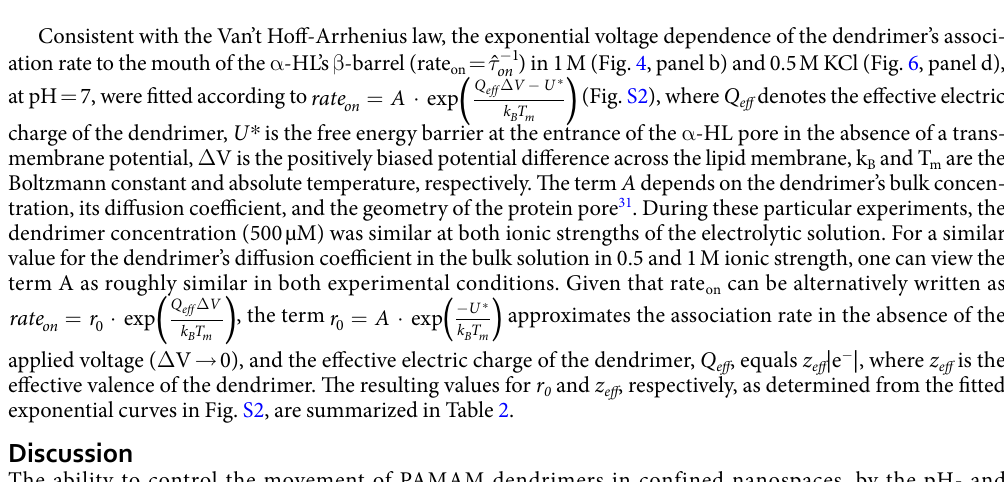
(Fig. S2), where Q eff denotes the effective electric